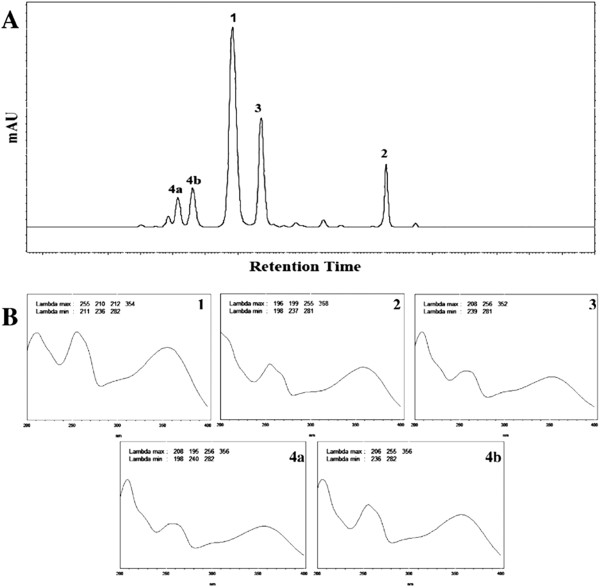
HPLC-DAD analysis detects flavonoids in extracts from B. longifolia. (A) 365 nm diode array chromatogram of EtOAc fraction from the leaves of B. longifolia. (B) UV spectra of quercetin derivatives present in the EtOAc fraction.